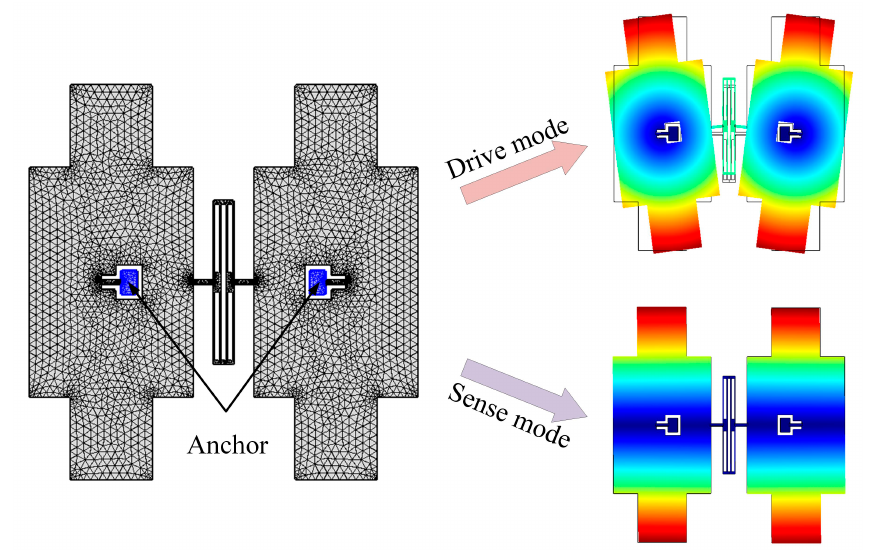
Figure 10. The simulation condition in the COMSOL software.